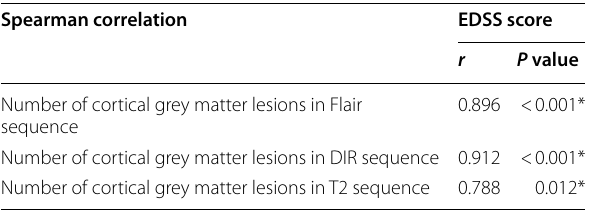
Table 3 Percentage of the distribution of multiple sclerosis plaques in different anatomical locations of the brain among studied MS patients